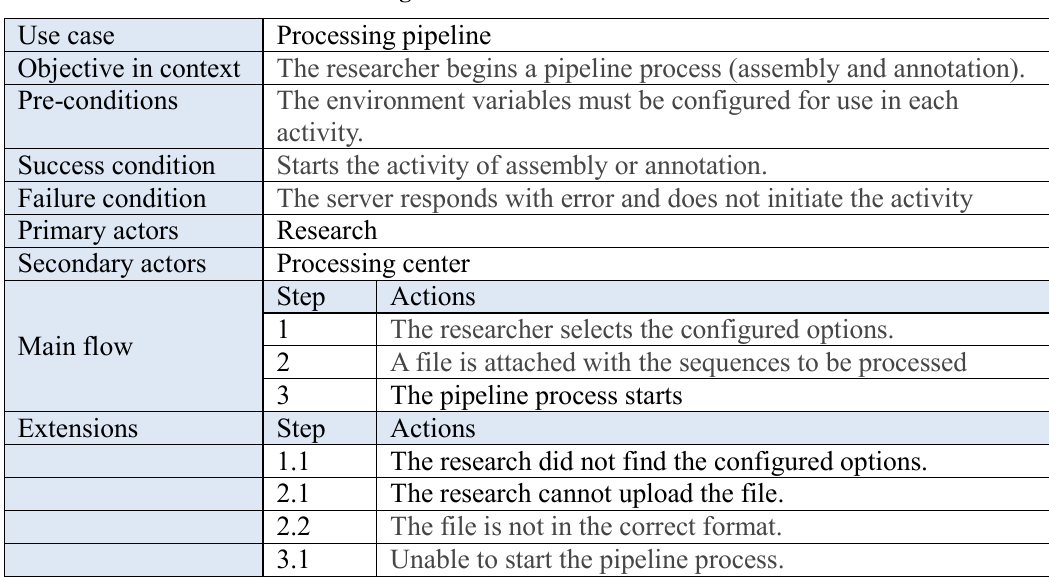
Figure 2: Case Use